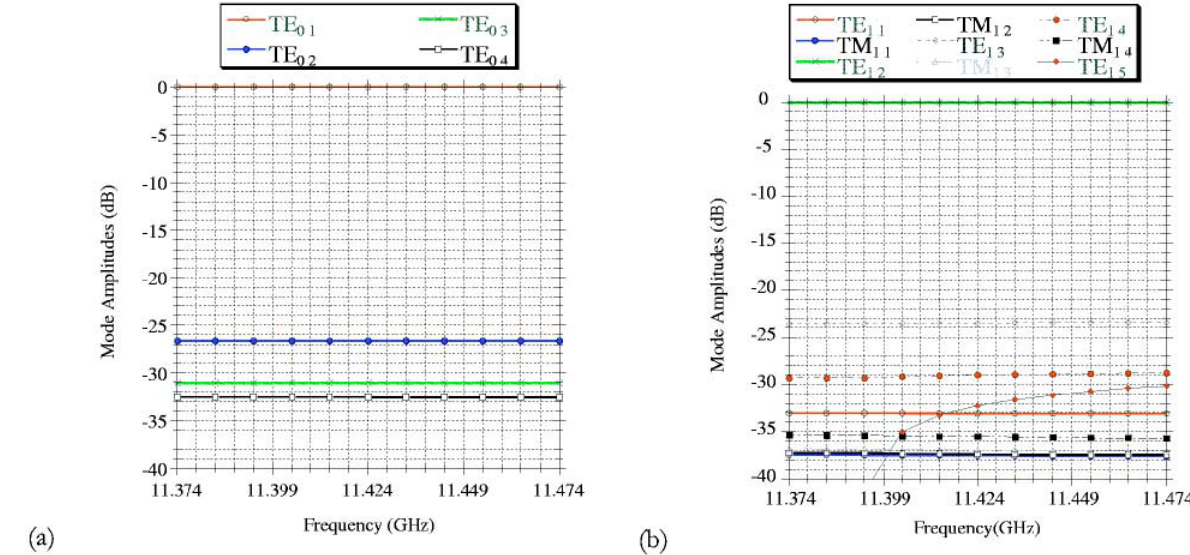
FIG. 3. (Color) (a) The scattering of modes due to the step discontinuity when the incident mode is the TE 01 mode. (b) The scattering of modes due to the step discontinuity when the incident mode is the TE 12 mode.